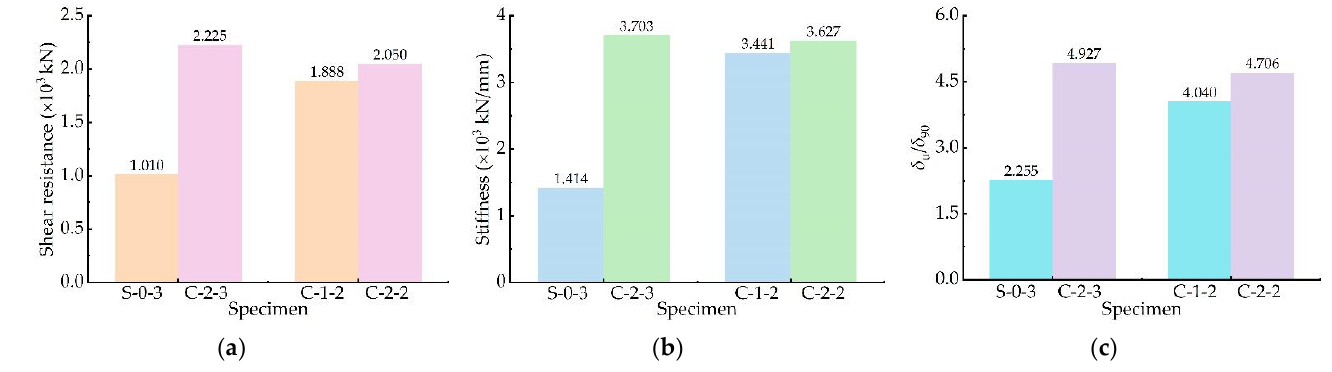
Figure 12. Influence of perforated hole number: ( a ) shear resistance; ( b ) shear stiffness; ( c ) ductility.